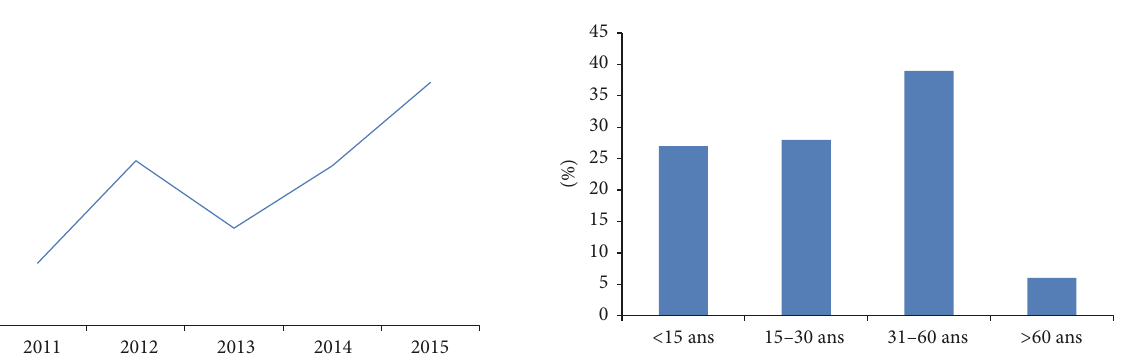
Figure 1: Evolution of the intestinal parasitic infections according to years.